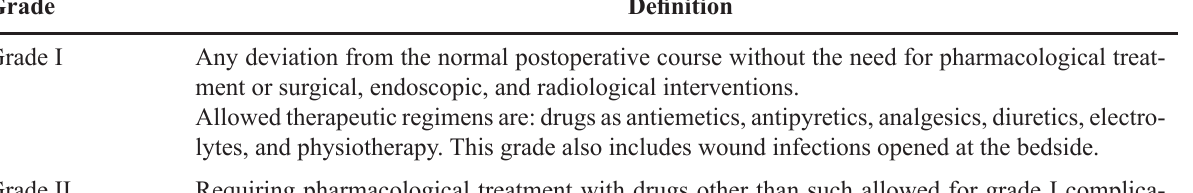
Laparoscopic Radical Prostatectomy: A Review